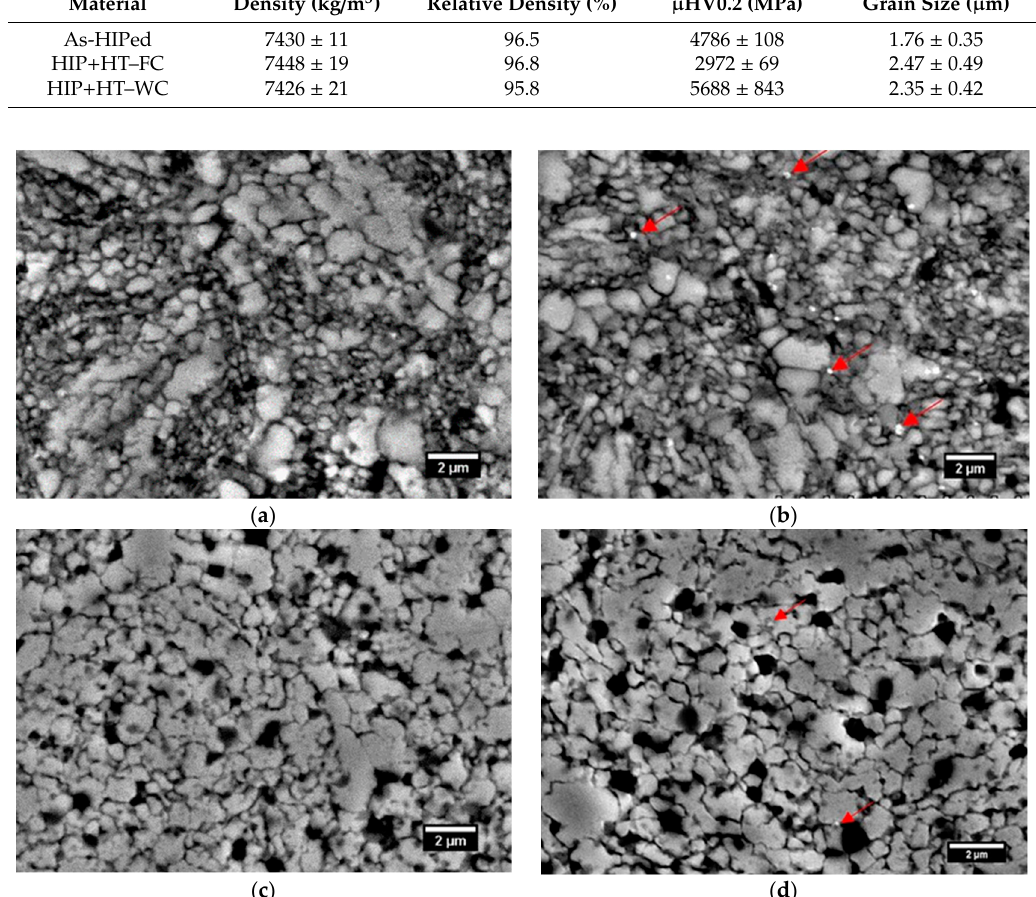
Figure 8. SEM images of the HIPped and HT sample at 1175 ° C: ( a ) and ( b ) as-HIPed, ( c ) and ( d ) HIP + HT and water cooled.